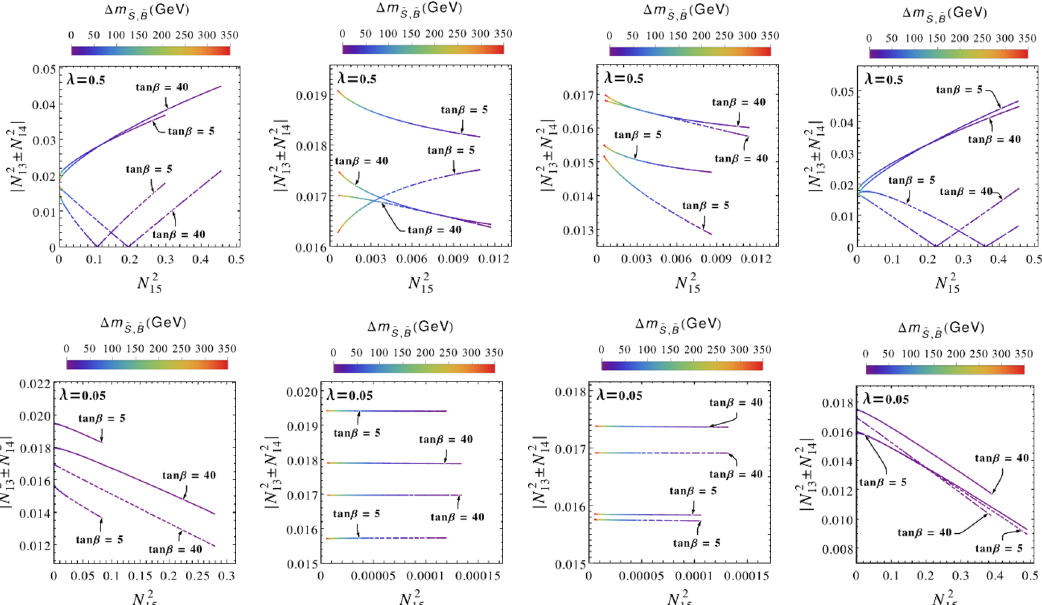
) and the overall higgsino admixtures ( N 2 + 15 13 − N 2 | ; broken lines) in an 13 14 (in the palettes) arising from the variation e S, e B ) ≡ (++ , + − , − + , −− ) . M is kept 1 , m 2 e S